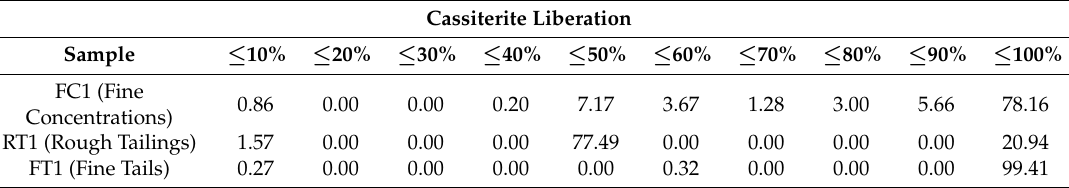
Table 5. Cassiterite liberation. 80% liberation is required for mineral processing. Cassiterite